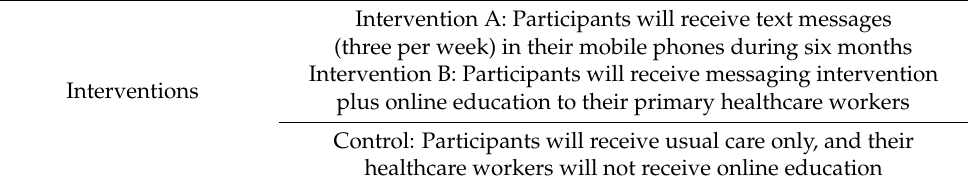
Figure 4. Phase II PreDiabeText study timeline.